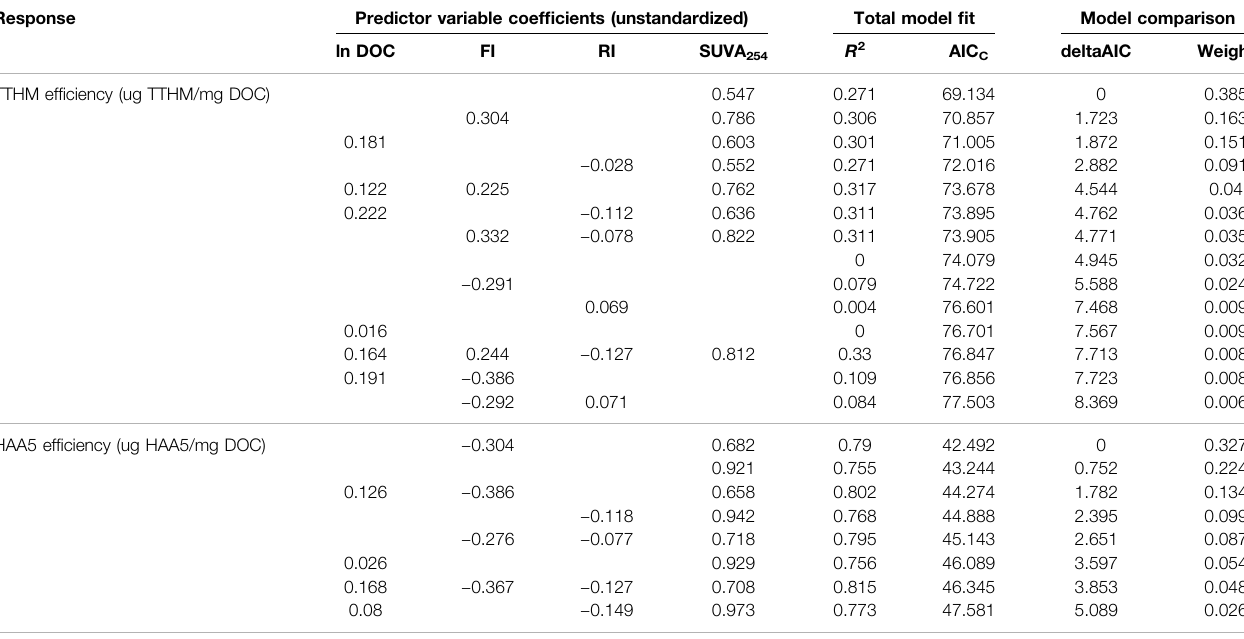
TABLE 2 | Model comparison results for linear models predicting TTHM and HAA5 yield ef fi ciency (µg DBP/mg DOC). Response Predictor variable coef fi cients